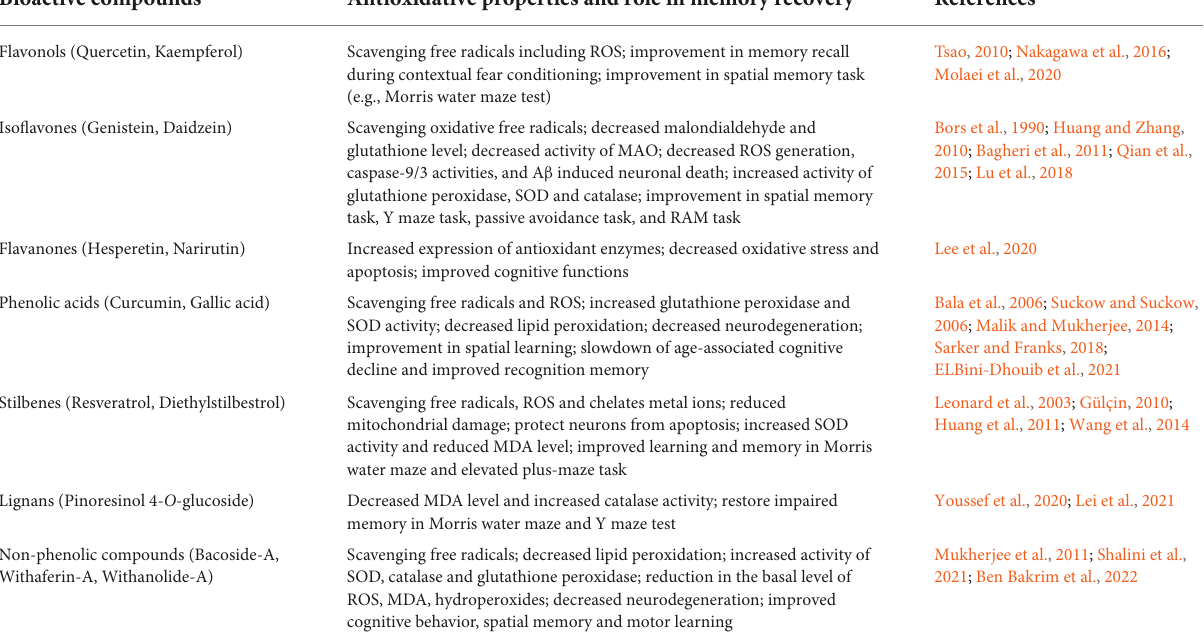
TABLE 2 Antioxidative properties of plant-derived bioactive compounds and their involvement in memory recovery. Bioactive